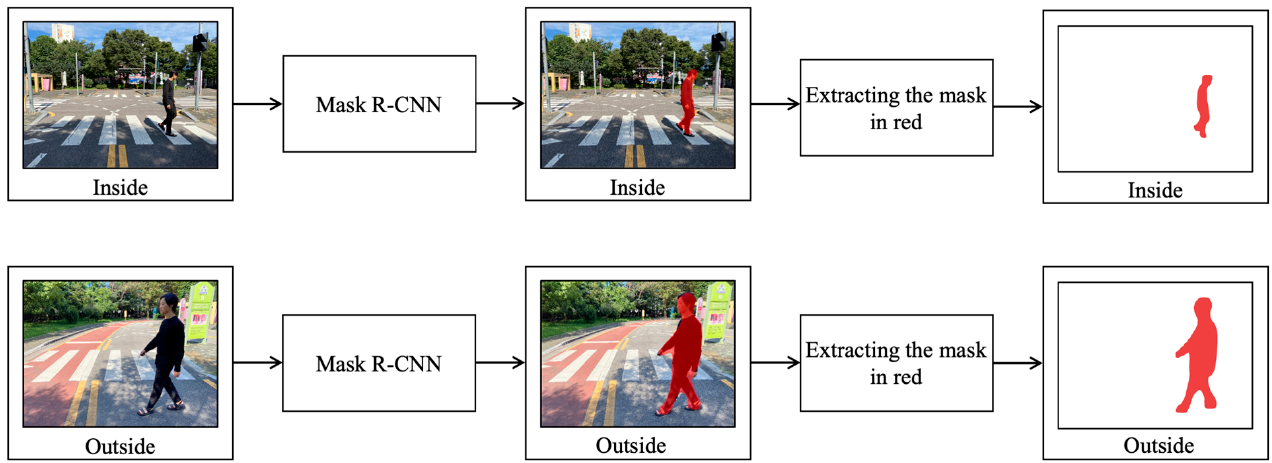
Figure 3. Detecting a pedestrian using Mask R-CNN.